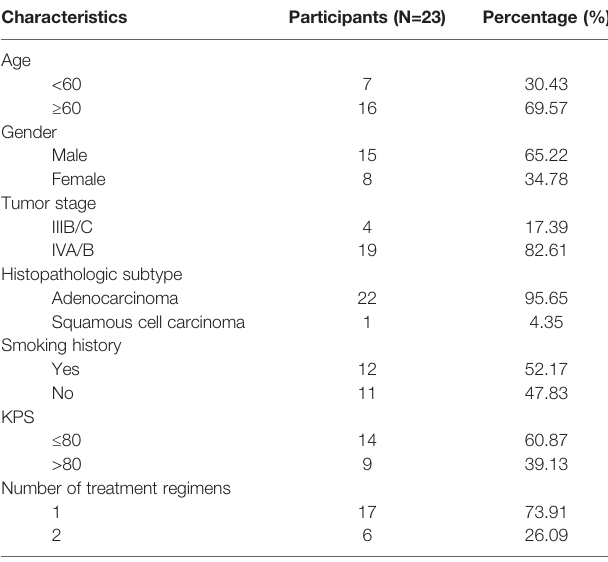
TABLE 1 | Patient